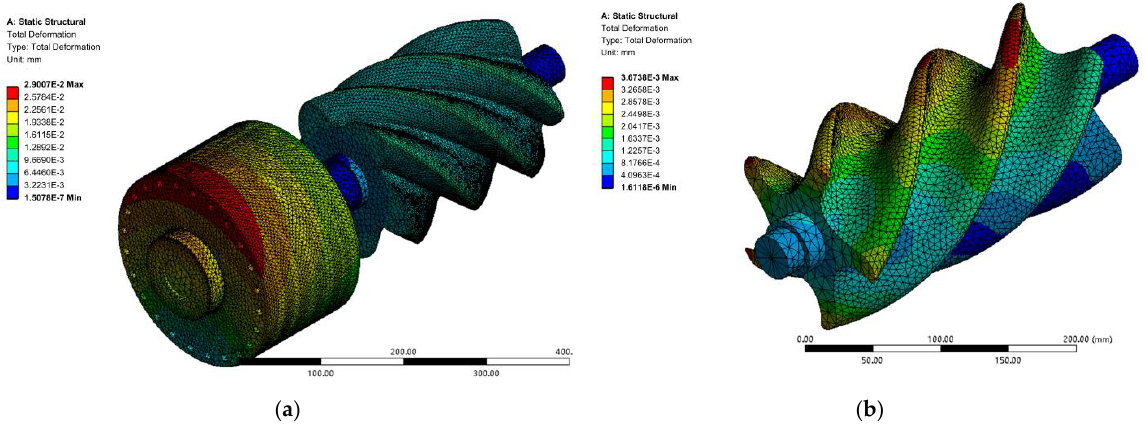
Figure 7. Deformation calculation results: ( a ) deformation calculation results of male rotor; ( b ) deformation calculation results of female rotor.